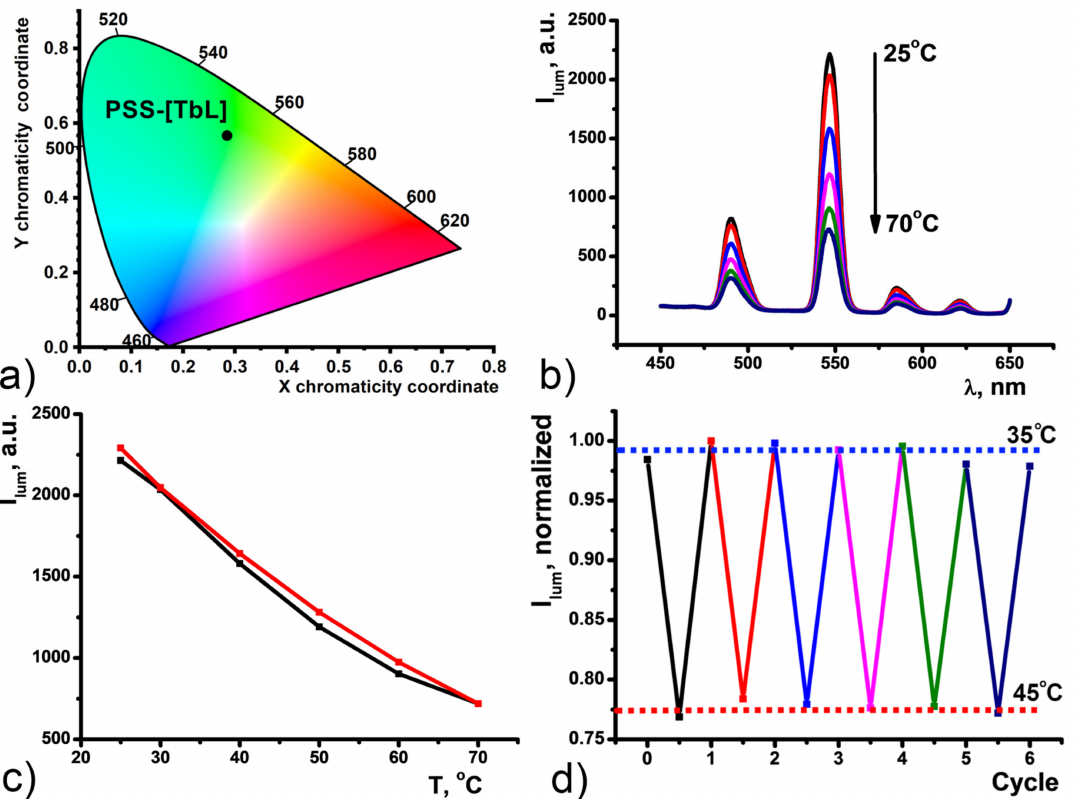
Figure 5. ( a ) Chromaticity diagram for PSS-[TbL]. ( b ) Temperature dependence of PSS-[TbL] emission spectrum upon heating. ( c ) Changes in the fluorescence intensity of the PSS-[TbL] (l ex = 360 nm) as a function of temperature under the heating (red) and cooling (black) within the 25–70 ◦ C range. ( d ) Normalized fluorescence intensity upon six heating-cooling cycles of PSS-[TbL] under alternating temperatures of 35 ◦ C and 45 ◦